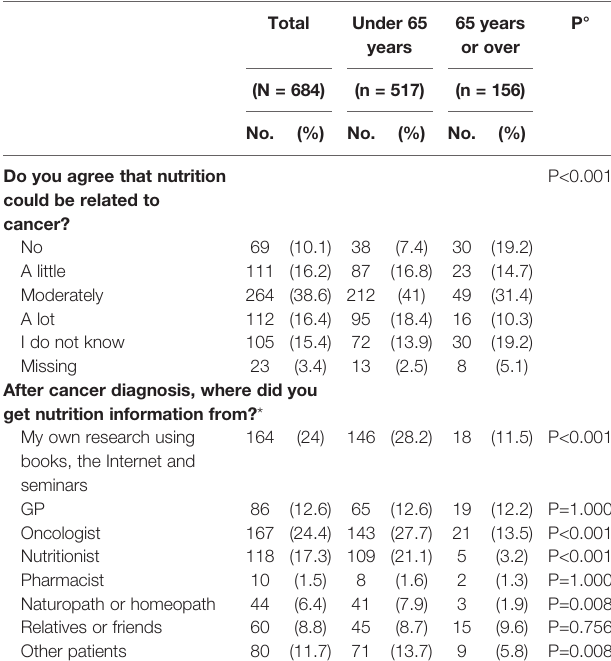
TABLE 5 | Beliefs toward cancer and